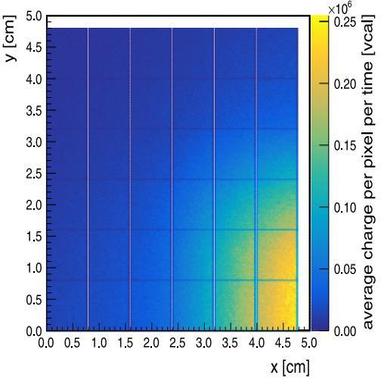
Design of the PSI46 quad board, which will be able to host four pixel detectors tiled in a two by two array.